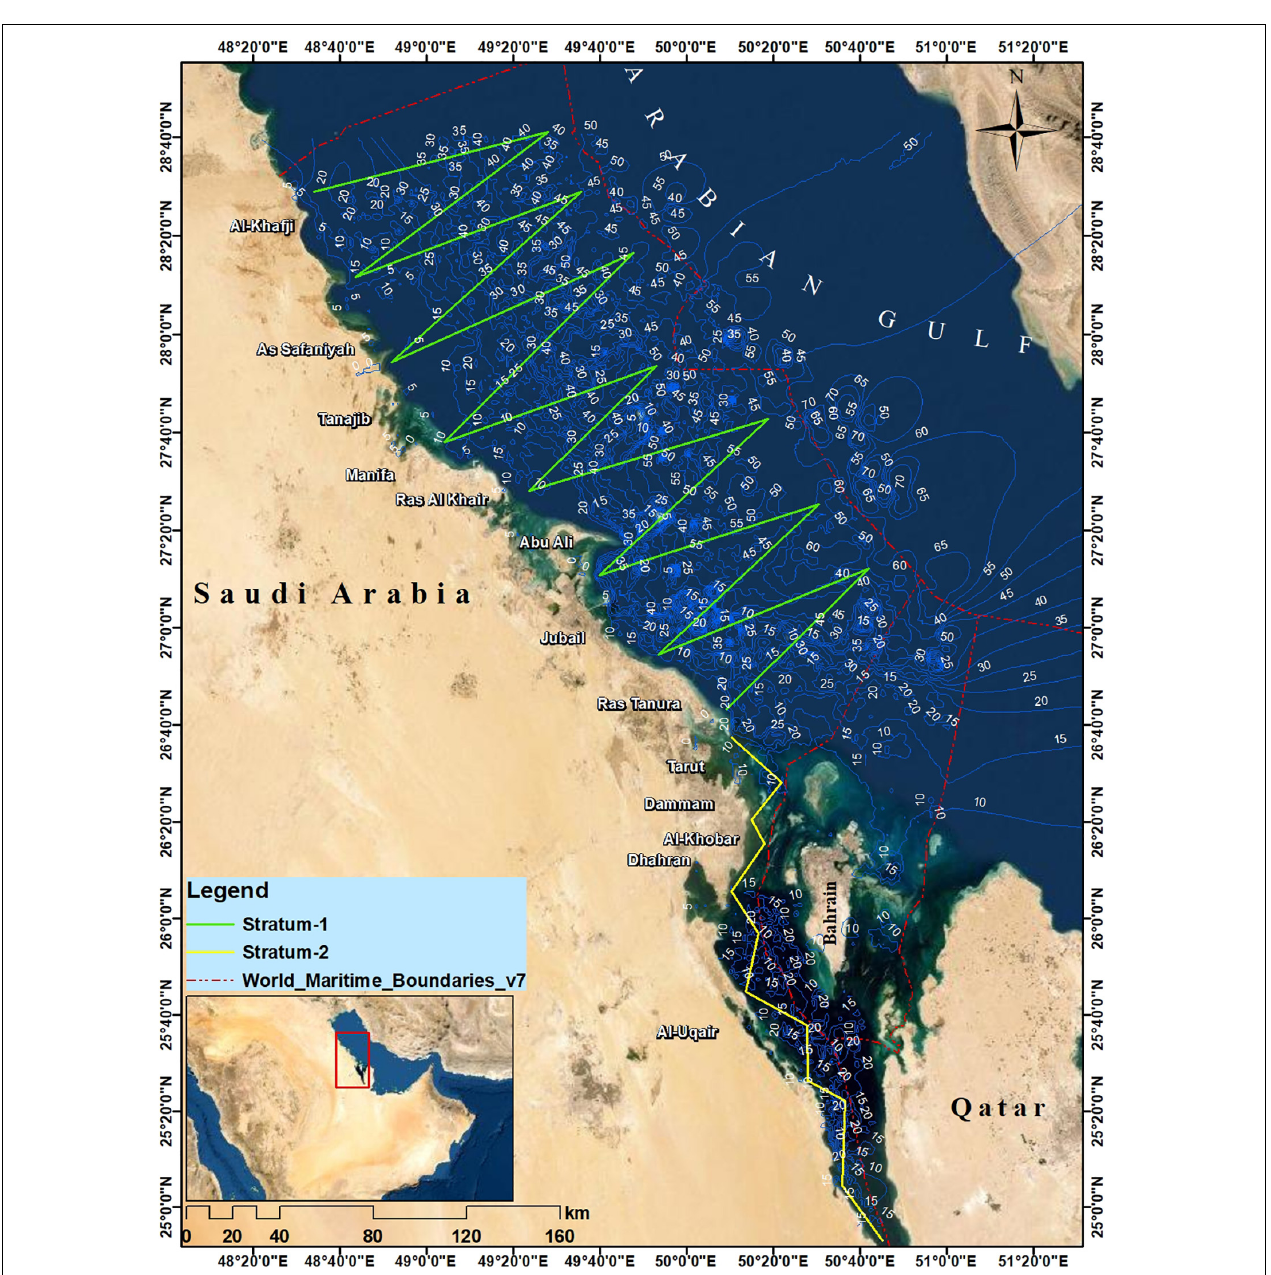
FIGURE 1 | Transects covered during the boat-based surveys conducted in Springs 2018 and 2019.